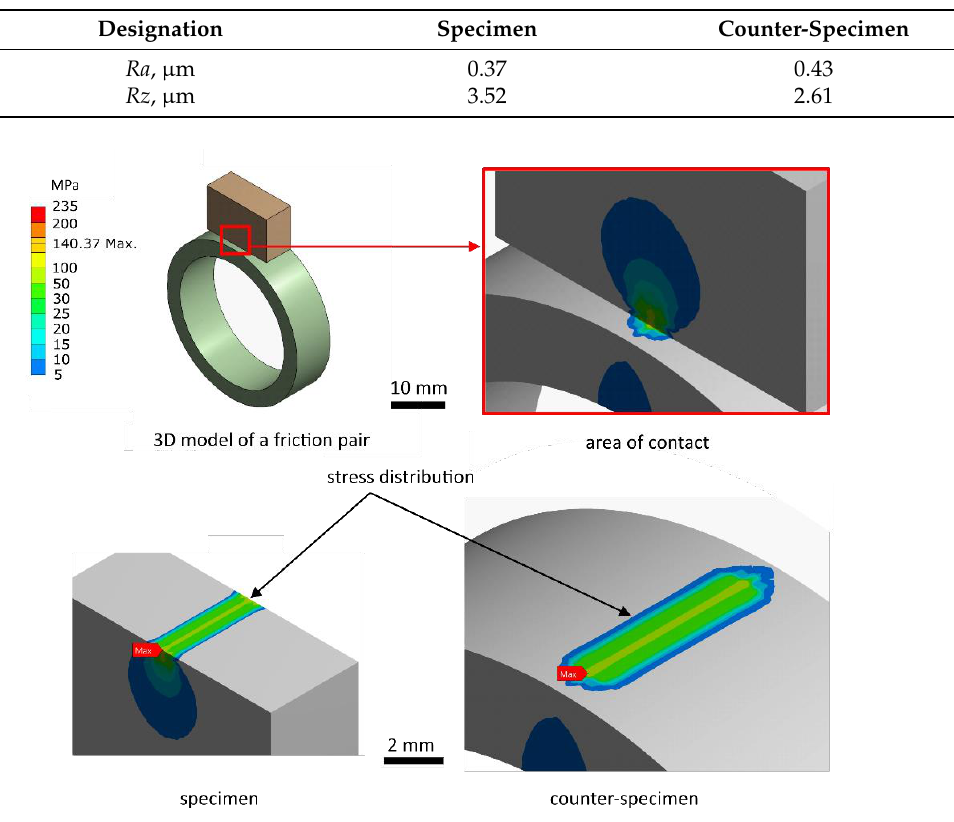
Figure 5. Stress distribution for the tested specimen and counter-specimen.